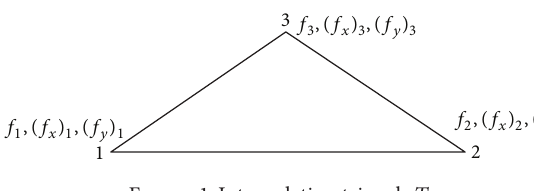
Figure 1: Interpolation triangle 𝑇 123